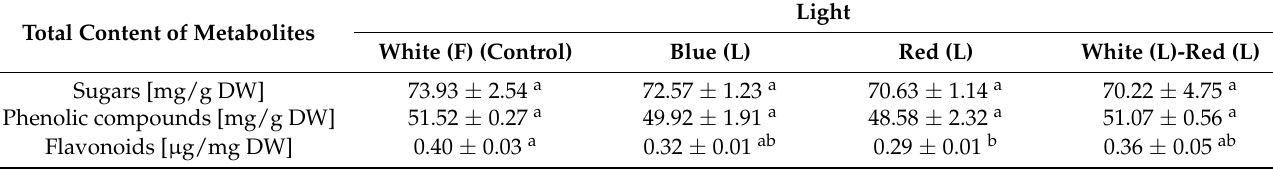
Table 2. Effect of different light conditions on total sugars, phenolic compounds and flavonoids contents in L. aestivum in vitro plants. The results are means of 3 replicates ( n = 3) ± SD.